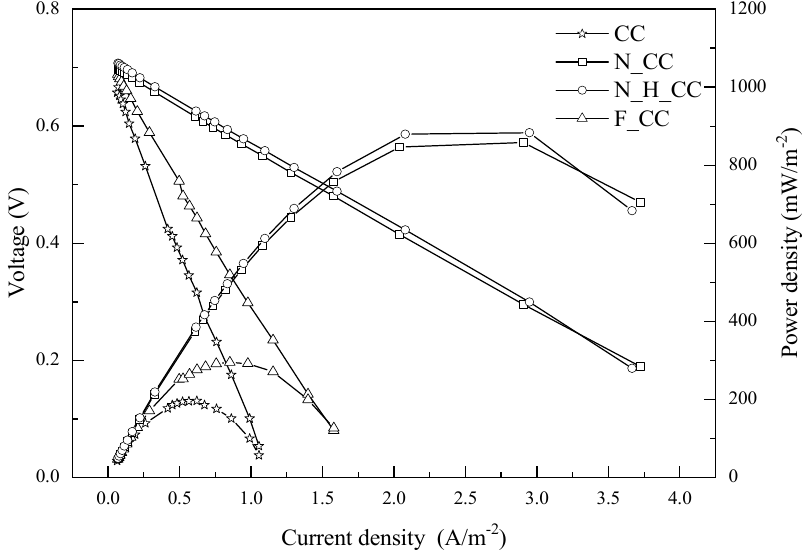
Figure 6. Power density and polarization curves of MFCs operated with CC, N_CC, N_H_CC, and F_CC.